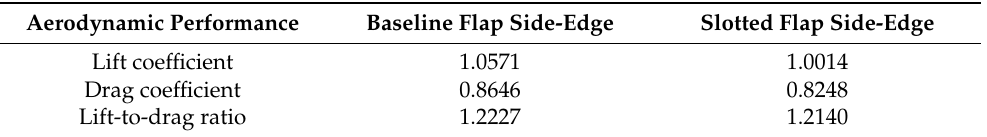
Table 2. The comparison of aerodynamics performance between the baseline flap side-edge and slotted flap